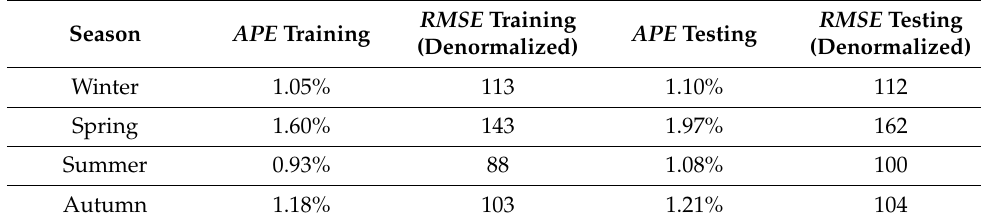
Table 4. Seasonal APE and RMSE for FCM ReNFuzz-LF .